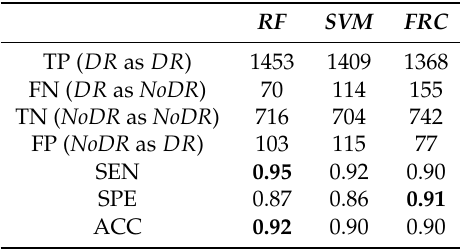
Table 6. Sensitivity (SEN), specificity (SPE) and accuracy (ACC) of the candidates for the coarse-grained classifier along with their number of true positives (TP), false positives (FP), true negatives (TN) and false negatives (FN).